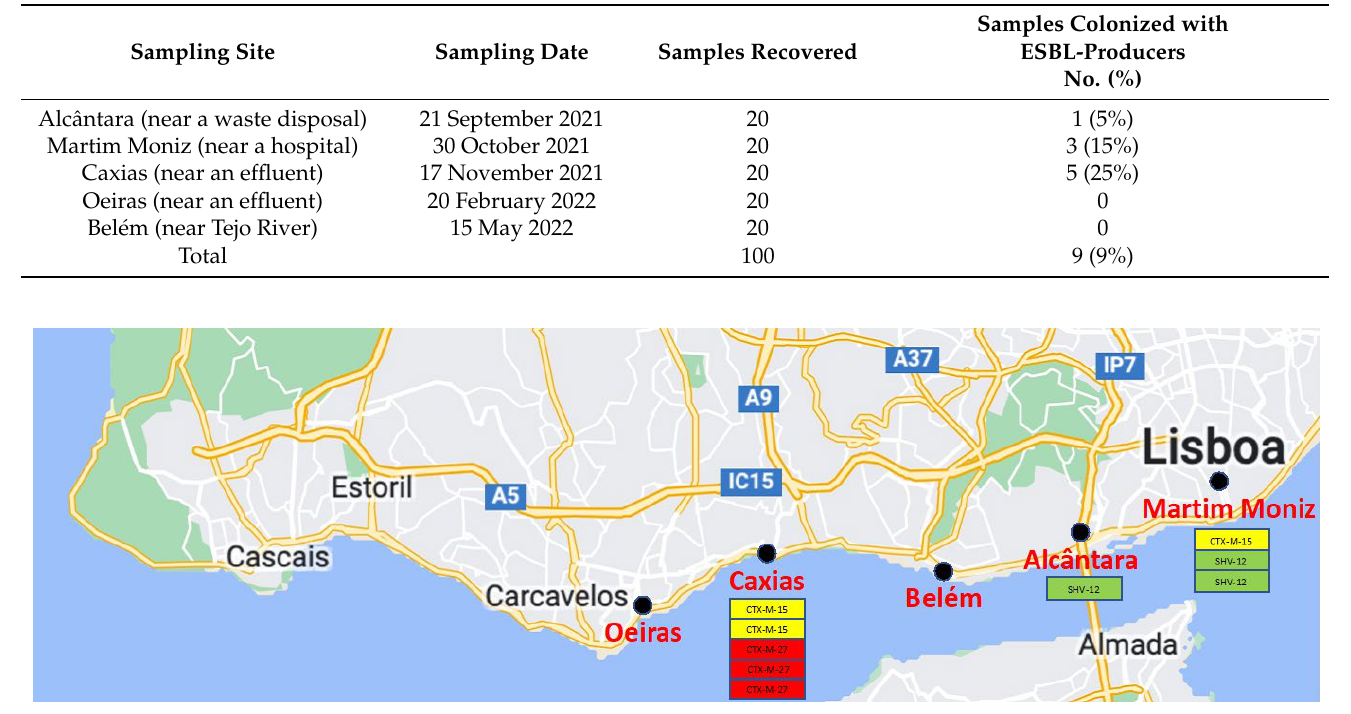
Table 1. Samples recovered and samples colonized with ESBL-producers.